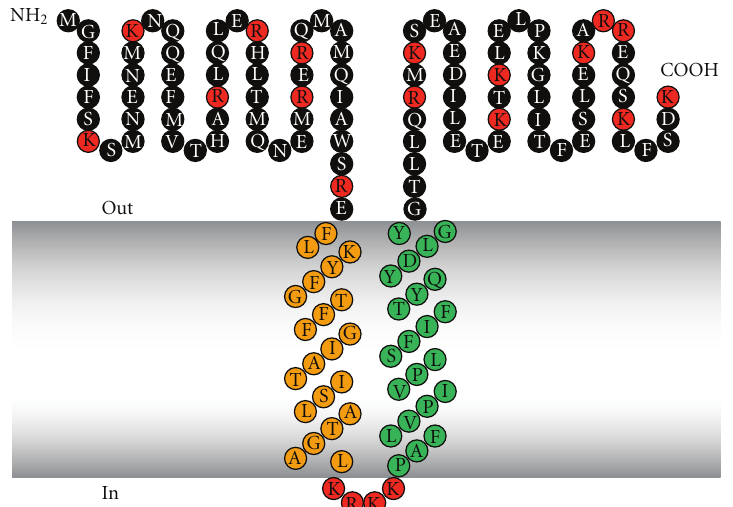
Figure 6: Structural model of Plg-R KT . Green indicates amino acids within the predicted primary transmembrane helix. Orange indicates amino acids within the predicted secondary transmembrane helix. Red indicates basic amino acids. [18].